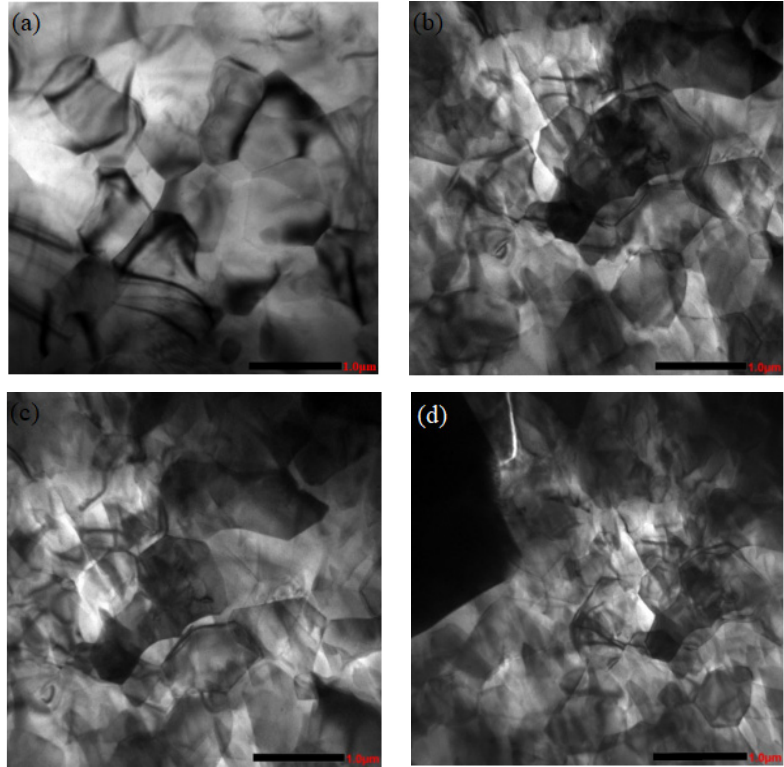
Figure 7. TEM morphologies of the SiC p /AZ91D matrix under different pulse current peaks. ( a ) 0 A